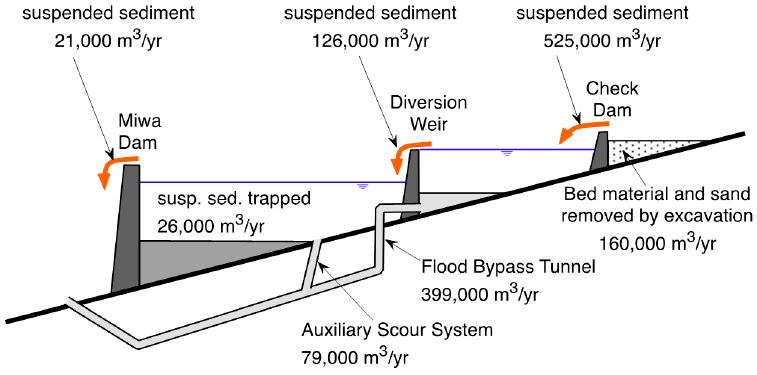
Figure 6. Bypass arrangement for Miwa dam, Japan (redrawn from [57]).